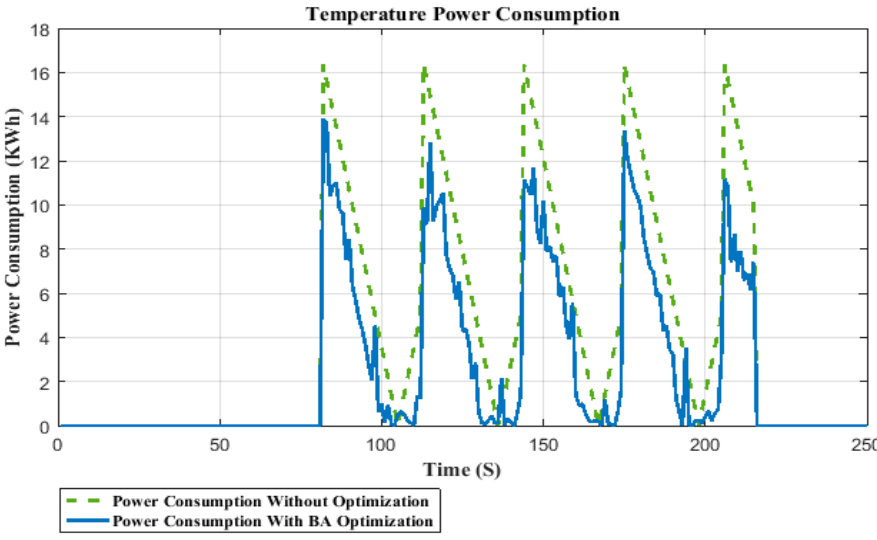
Figure 9. Power consumption for temperature with BA optimization and without BA optimization.